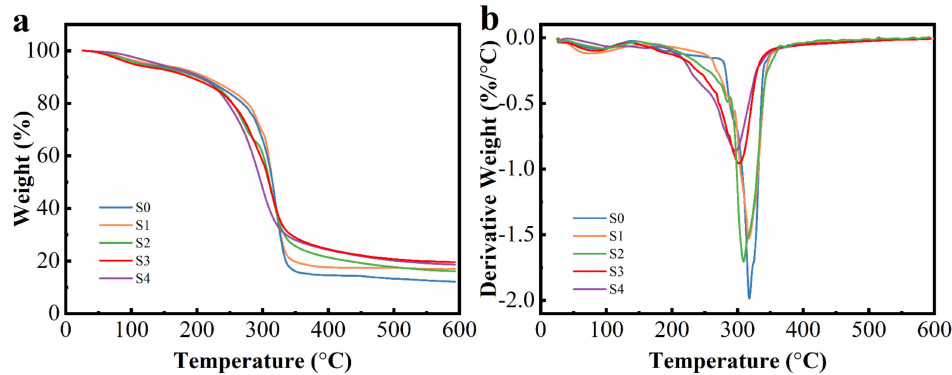
Figure 2. TGA ( a ) and DTG ( b ) curves of ADSP-based films added by different RCAE